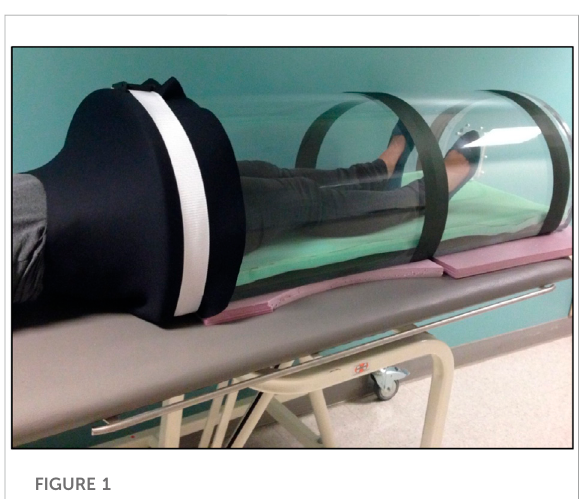
FIGURE 1 Dartmouth LBNP/LBPP device with neoprene